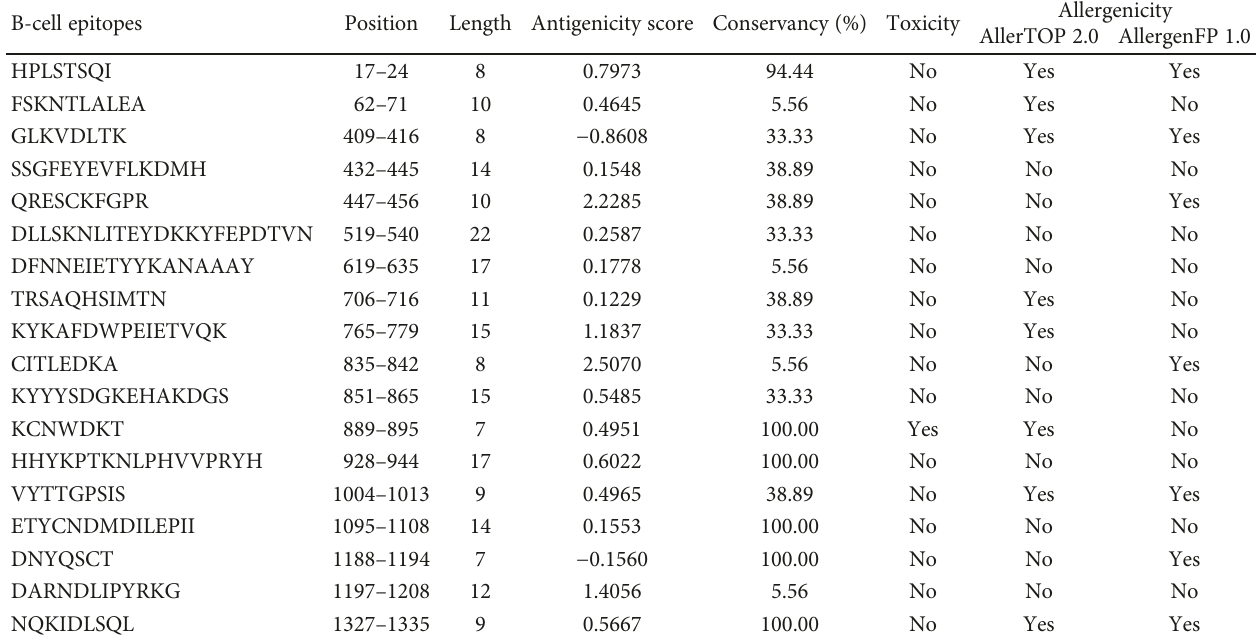
Table 5: Most conserved B-cell epitope sequences predicted by both BepiPred-2.0 and LBtope. B-cell